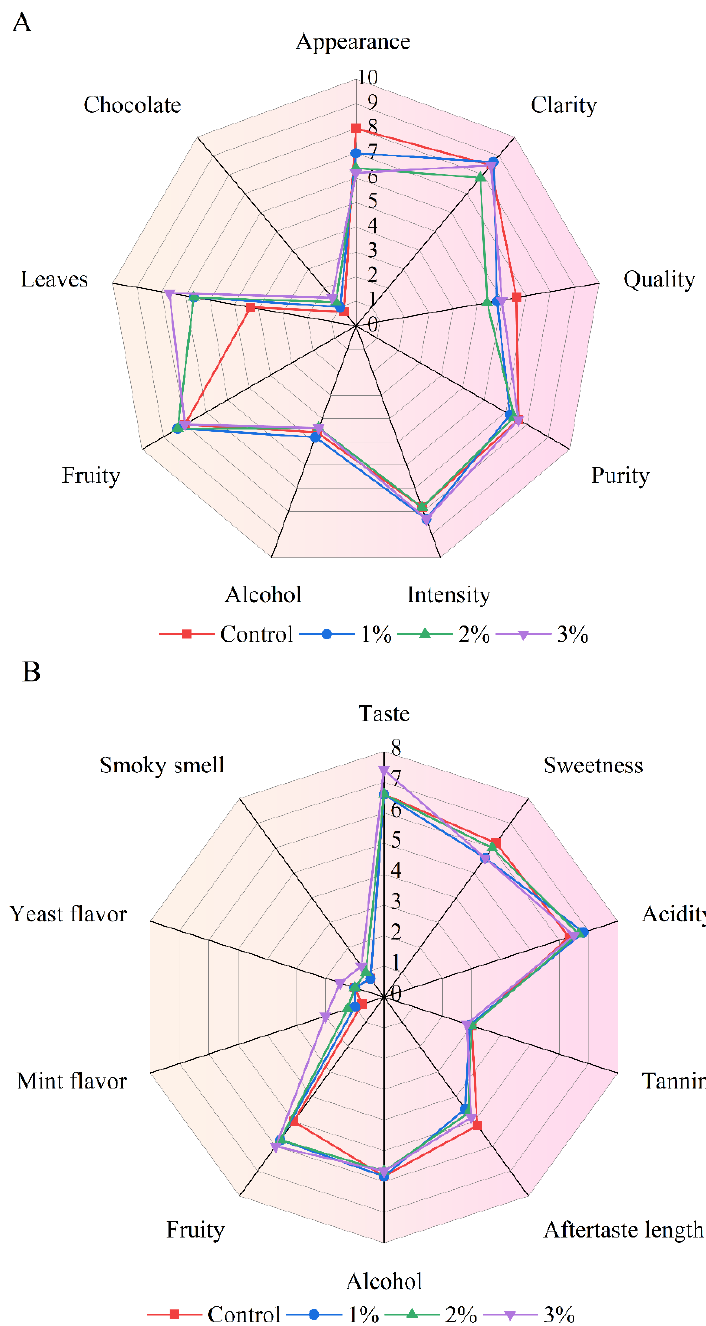
Figure 6. The appearance and aroma scores ( A ) and taste scores ( B ) of the four mulberry alcoholic beverages containing mulberry leaf powder after fermentation. Control represents without the addition of mulberry leaves; 1, 2 and 3% ( w / v , g/mL dry weight) represent the added amount of mulberry leaf powder.